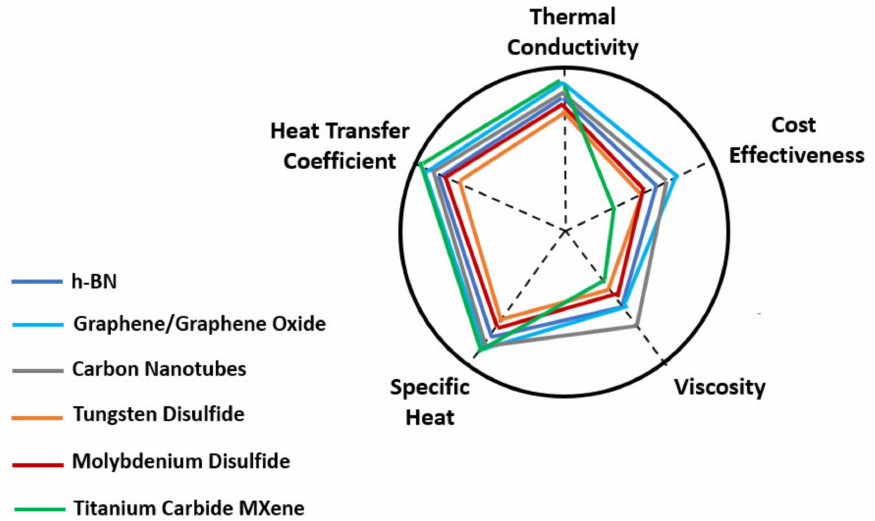
Figure 2. Schematic diagram of the qualitative comparison of the thermophysical properties of the main 2D